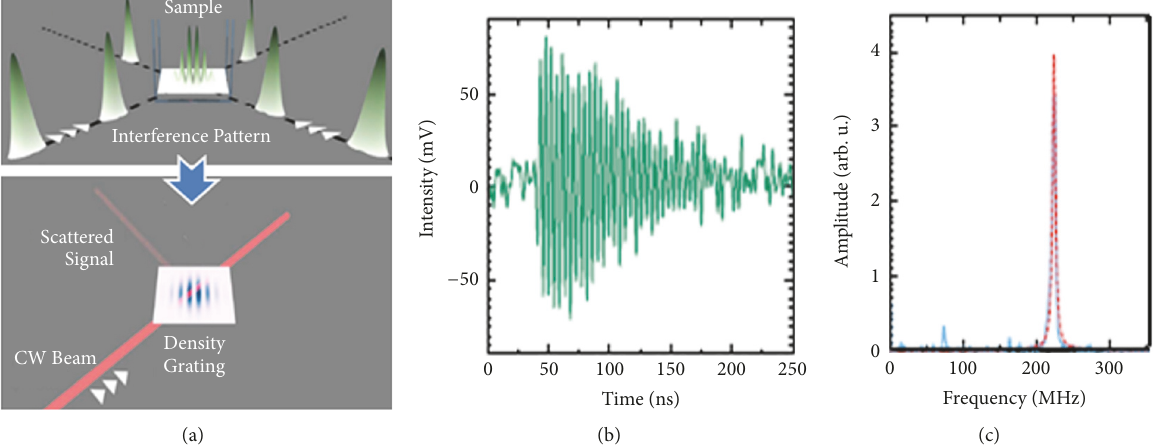
Figure 6: (a) Conceptual sketch of impulsive stimulated Brillouin scattering (ISBS), with psec pulses creating interfering acoustic waves through SBS. This modulates the probe, picked up by a high-speed photodetector, whose signal is shown in (b). The Fourier transform of this transient data is shown in (c), allowing direct determination of the Brillouin frequency shift and linewidth [adapted from [9]].